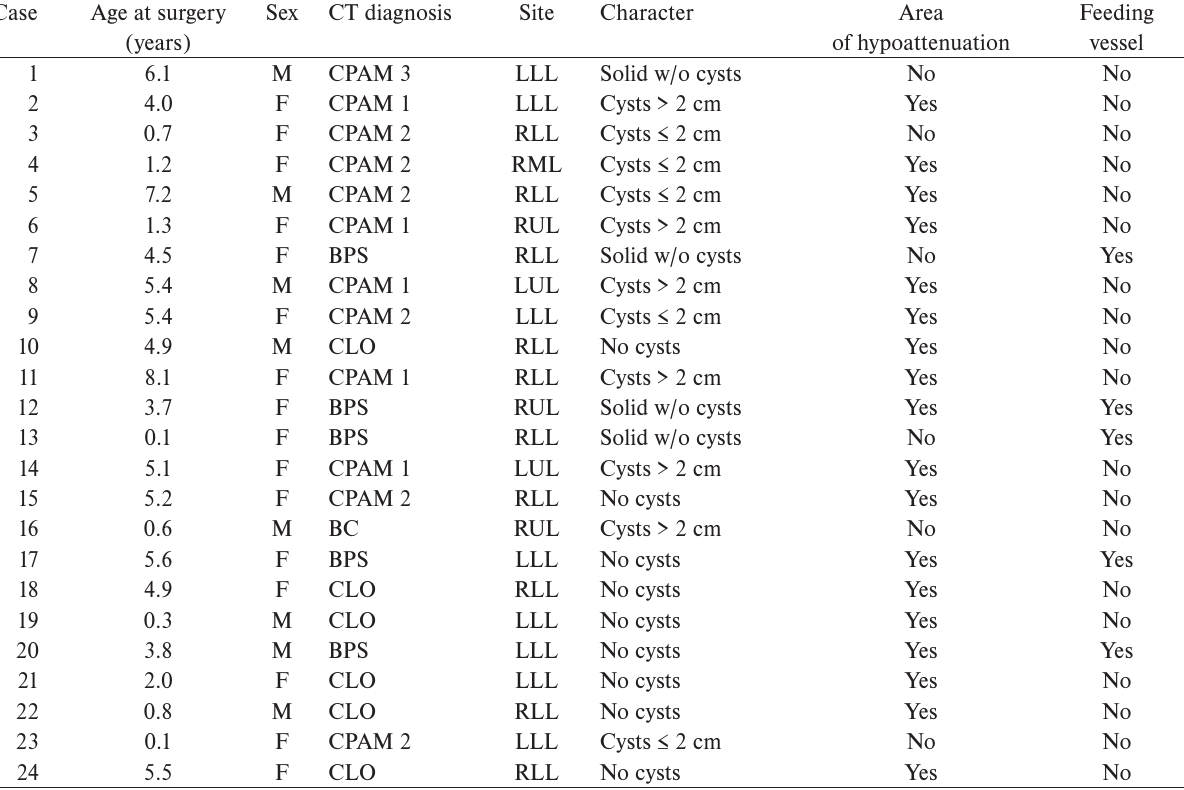
Table 1. Imaging characteristics of BPMs.